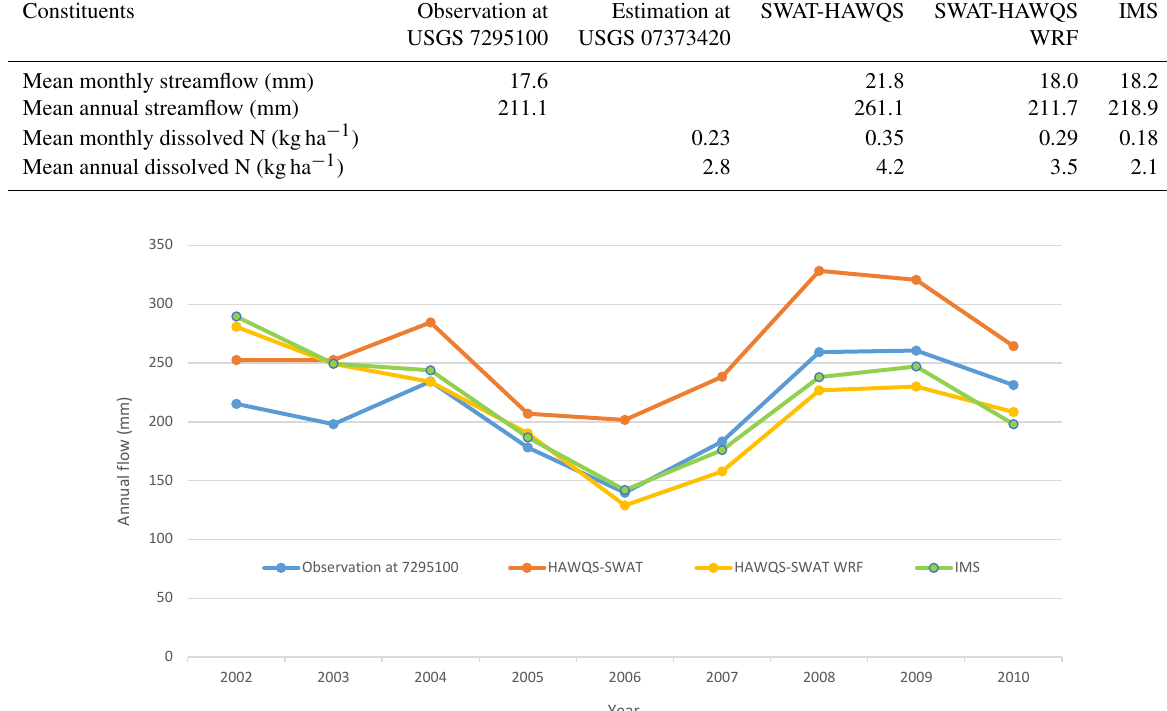
Figure 6. Annual streamflow evaluation at the USGS